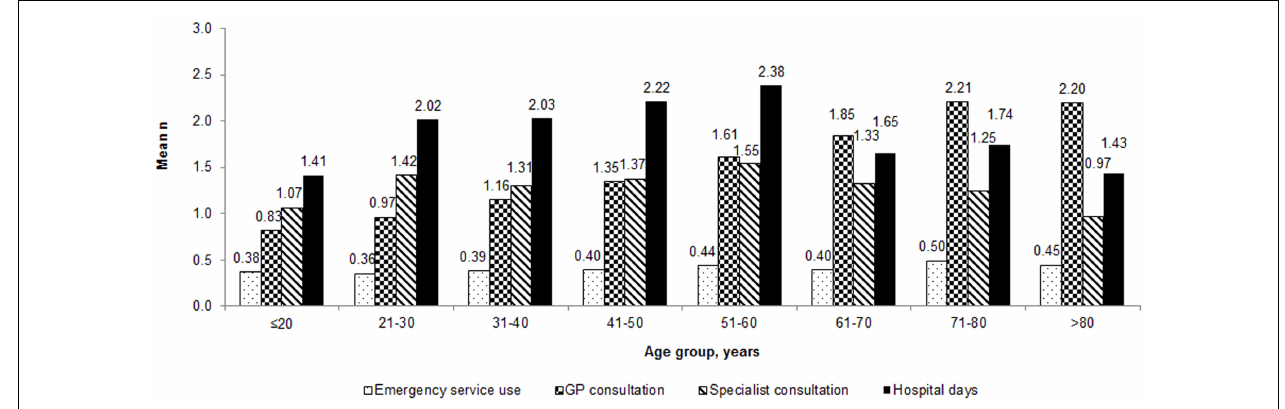
FIGURE 1 | Healthcare utilization by patients with vertigo during the 3months beforeVisit 1 by age group .